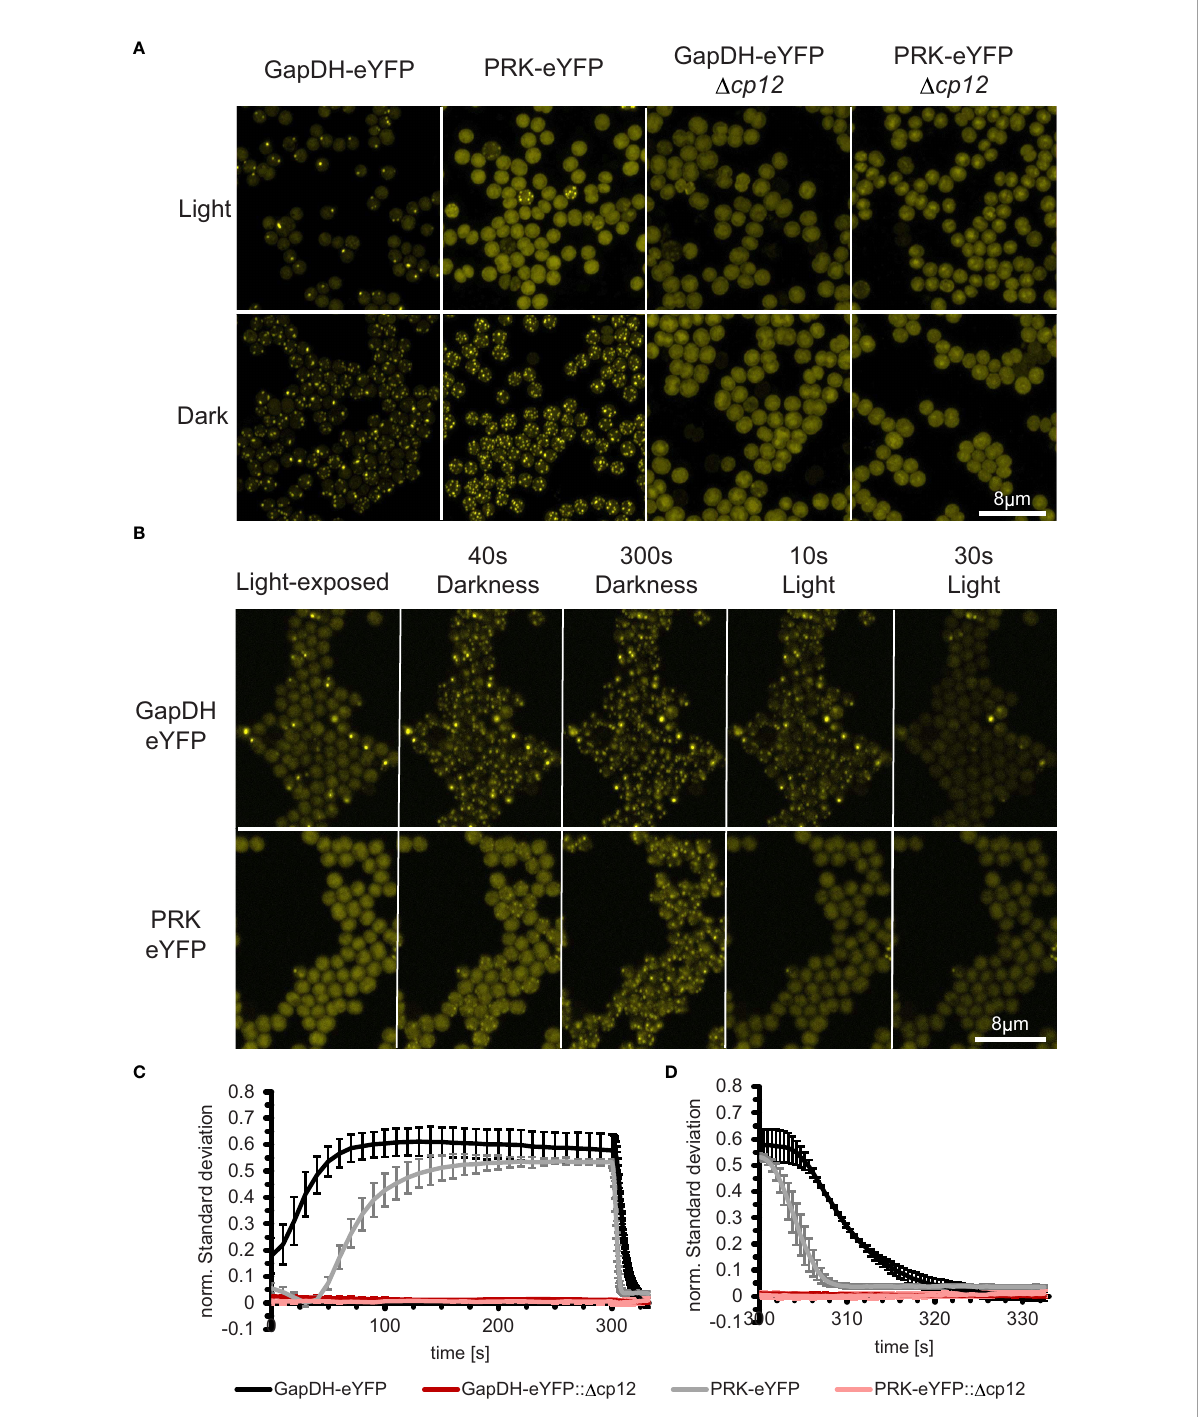
FIGURE 1 In vivo dynamics of CP12-dependent localization changes of the CBB enzymes GapDH2 and PRK in living Synechocystis cells during light/dark transition. (A) Fluorescence micrographs of Synechocystis cells that express GapDH2 or PRK tagged with eYFP in wild type (left two panels) or in D cp12 mutant background (right two panels). All cells were fi xed either in light or dark conditions before observation. (B) Light-exposed GapDH2-eYFP and PRK-eYFP strains were observed over 300 s after transferring into dark and subsequently 30 s into light conditions, respectively (selected time points are shown). (C, D) Kinetics of complex appearance (C) or disappearance (D) were estimated by plotting the time-dependent change in normalized standard deviations representing the heterogeneity of fl uorescence signal distribution inside the cells after transfer from light into darkness (C) or back into light (D)